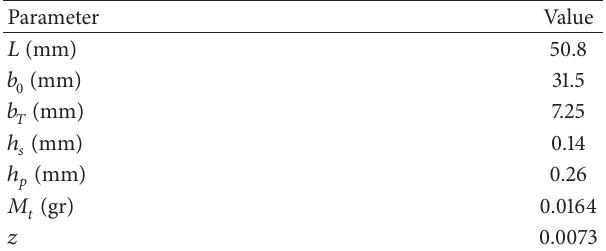
Figure 17: Comparison of 𝑉/𝑔 values between exponentially and linearly tapered energy harvesters. Table 4: Energy harvesters modelling